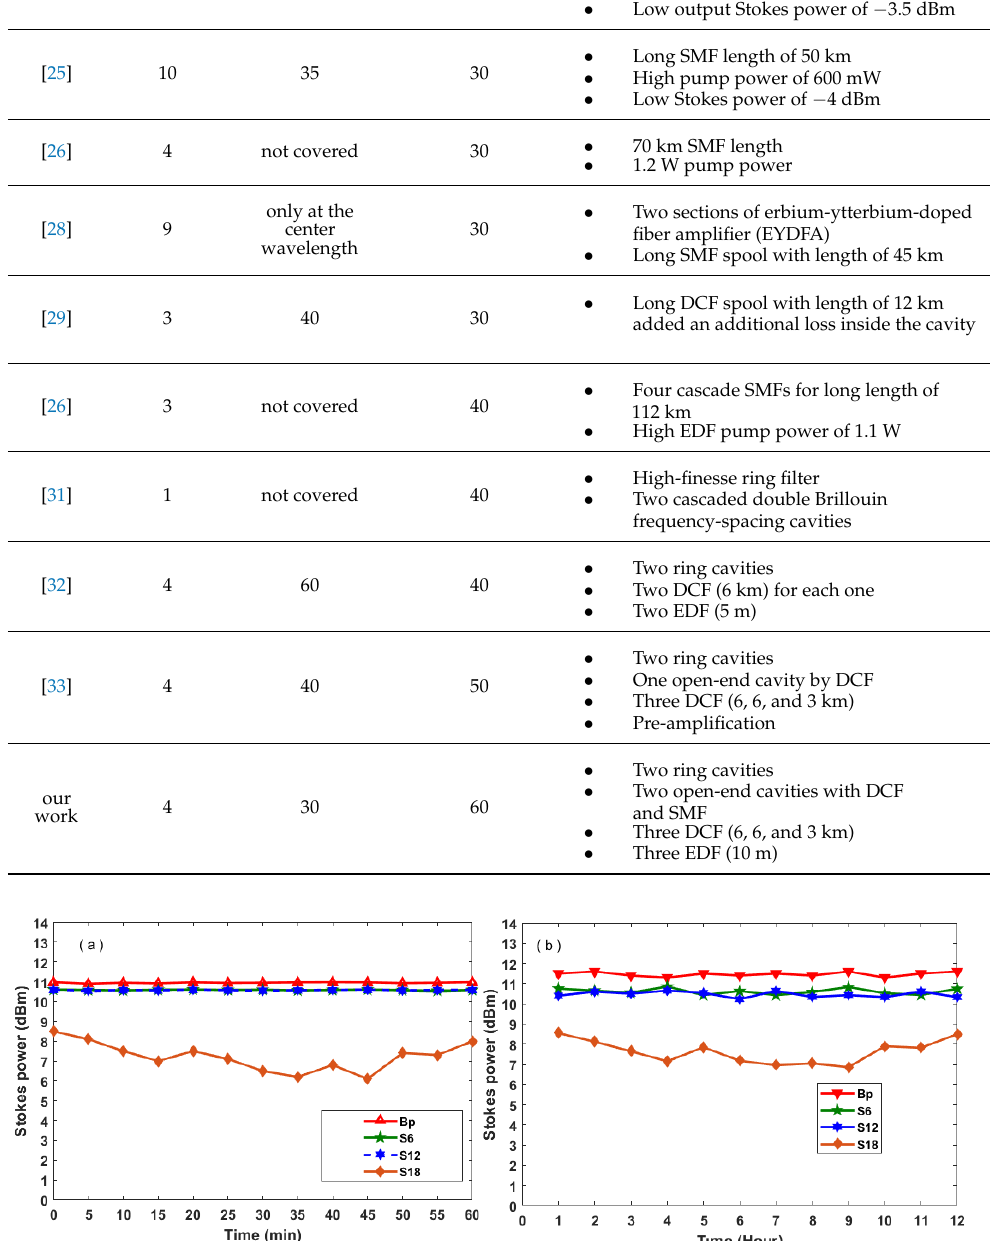
Figure 8. ( a , b ) Stability within two periods for the Bp, S6, S12, and S18 Brillouin Stokes signals at a pump power of 450 mW and a Bp wavelength of 1570 nm with a power of 25 mW.